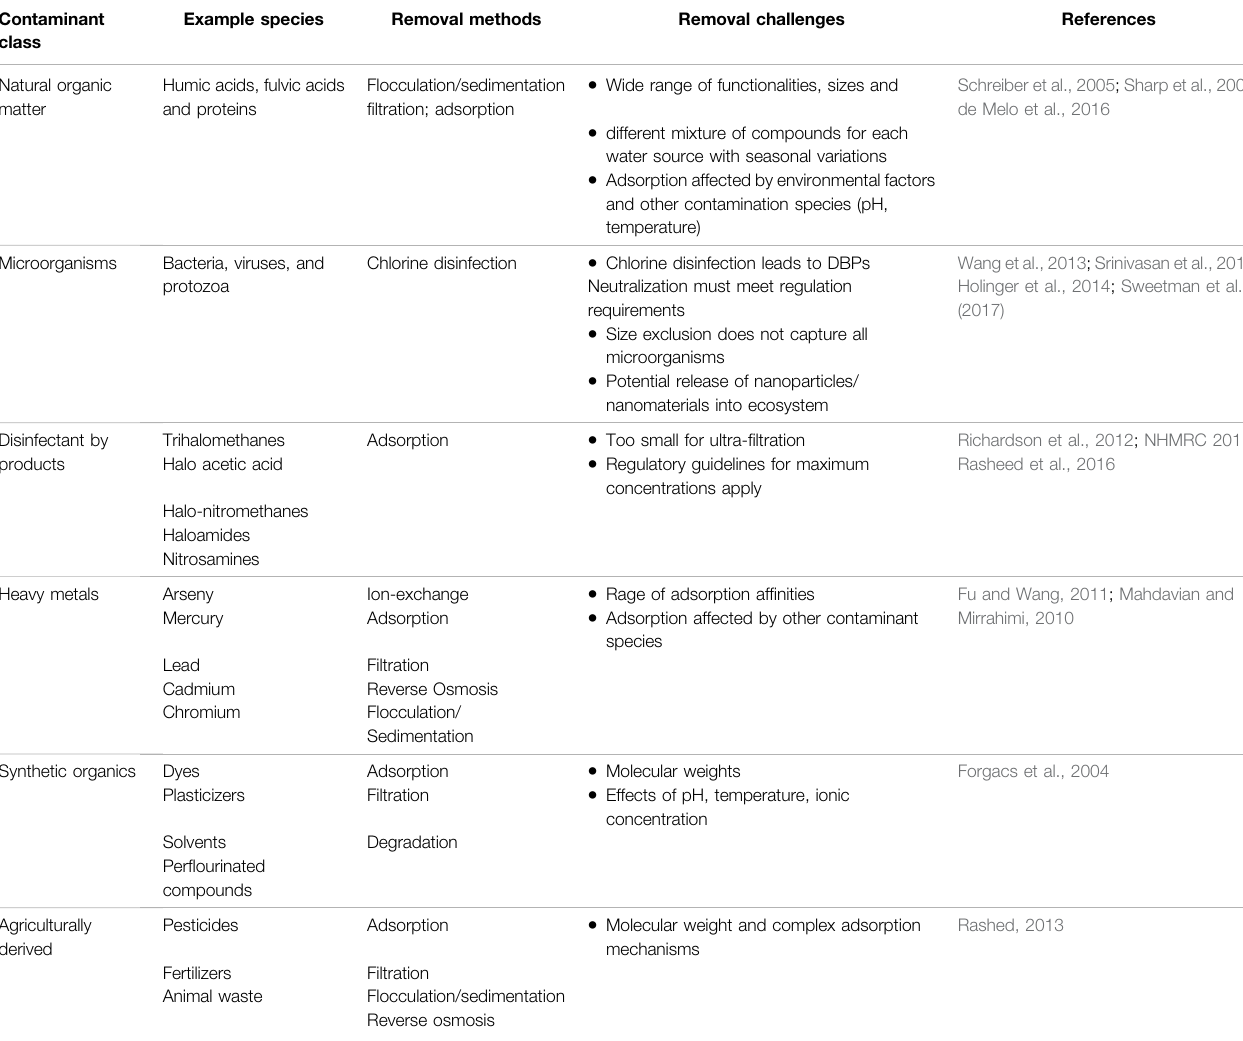
TABLE 1 | A summary of contamination type in water, removal methods and removal